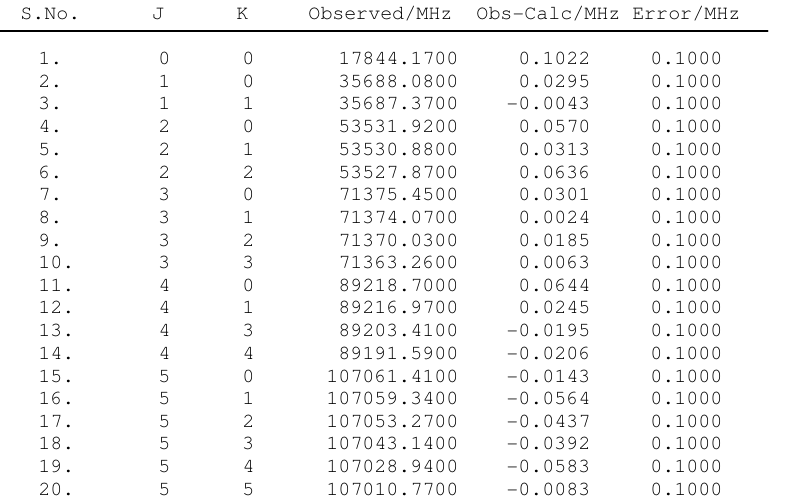
C 15 N in the ground state 22 . 3